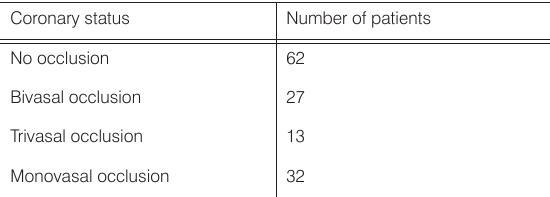
Table 6. Cineventriculography in the enrolled